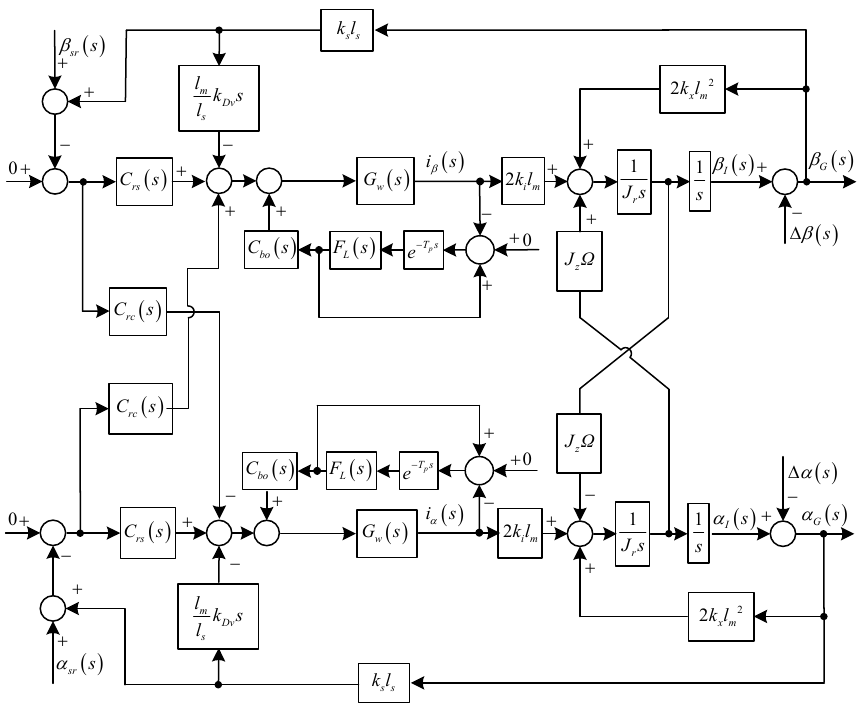
Figure 11. Diagram of the rotational system with the repetitive